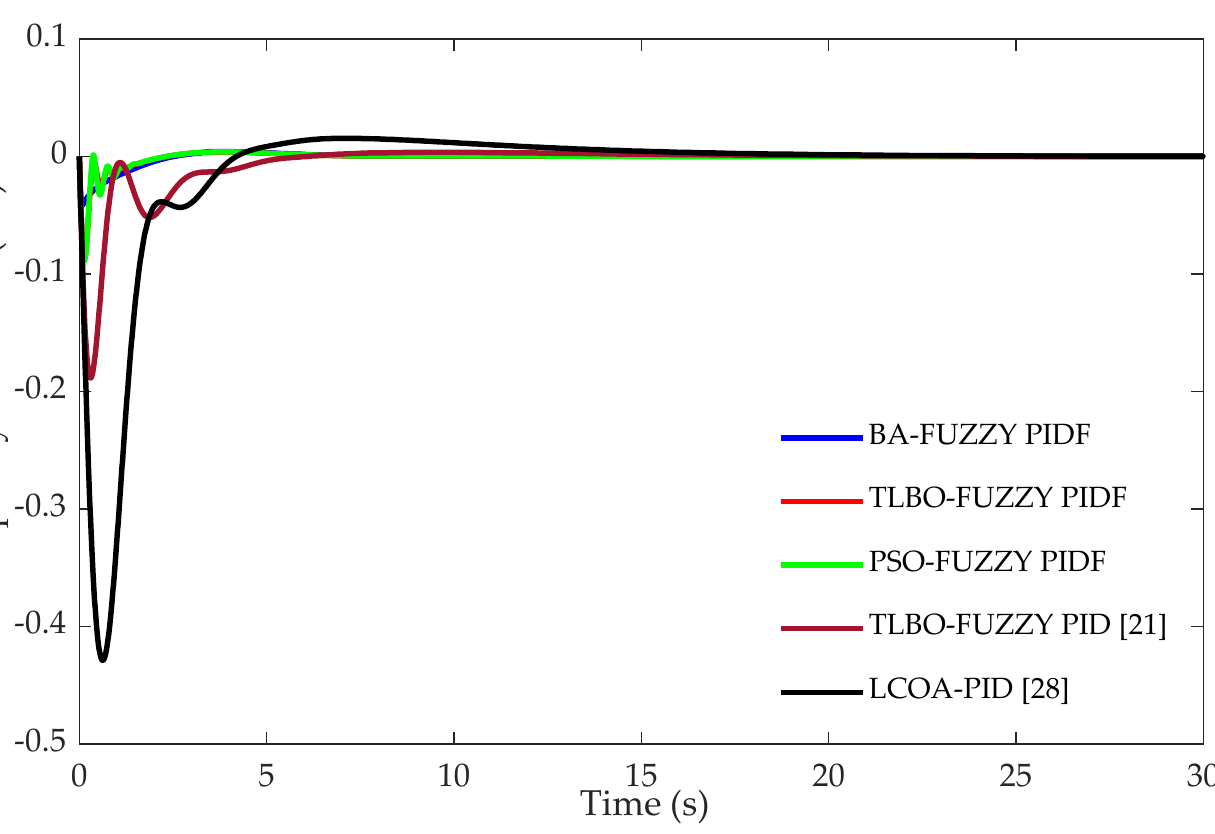
Figure 5. Frequency variation in area one ( ∆ F 1 in